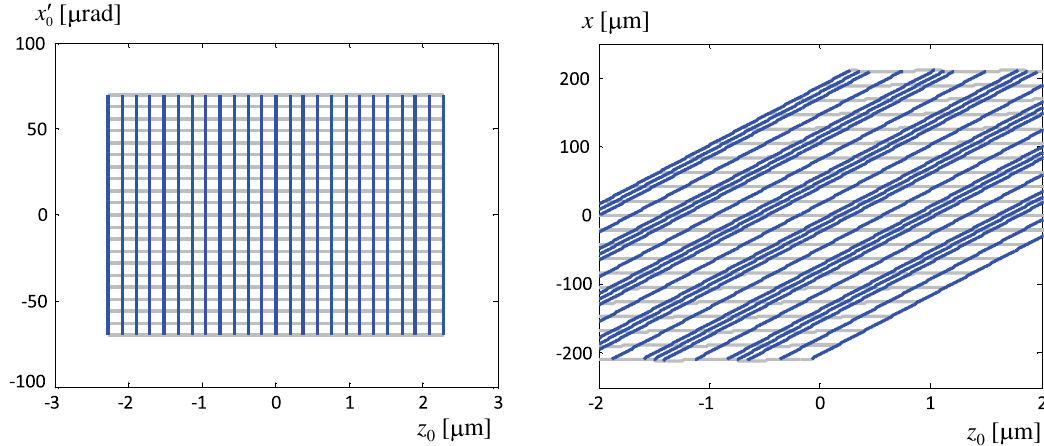
FIG. 17. Application C: visualization of transport transformation of ð z 0 ; x 0 0 Þ , after laser heater undulator to ð x; z Þ , at 15.5 m position for particles without offset x 0 .